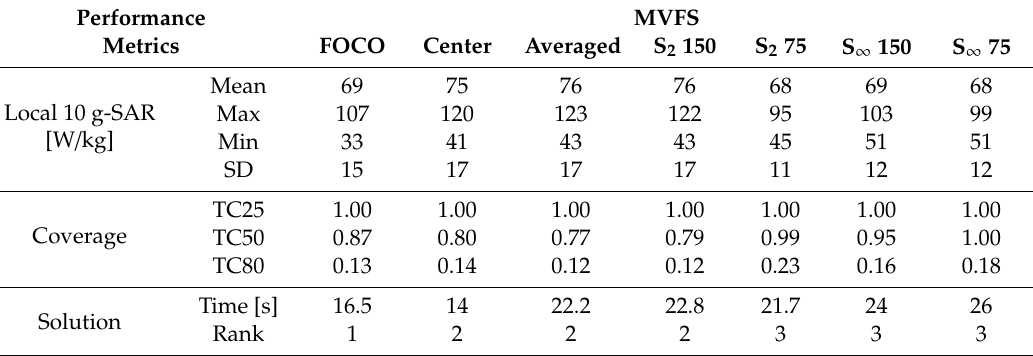
Table 2. Comparison of multiplexed vector field shaping (MVFS) to focused constrained power optimization (FOCO) for the single tumor model using 40 channels and single frequency fields at 600 MHz. Results are separated into SAR statistics, tumor coverage, and solution details. FOCO was performed using a rank-1 approximation of the central tumor SAR matrix and compared to six di ff erent MVFS application scenarios. “Center” uses the full-rank central SAR matrix, “Averaged” utilizes a single target matrix built from averaging over the whole tumor volume. The remaining four examples used all 257 tumor SAR matrices to derive a field shaping (“S”) result. Here, the subscript defines the target norm used (either 2 or ∞ ) and the following number stands for the target SAR in W / kg (either 75 or 150 W / kg). The “Rank” row describes how many time-interleaved solutions were identified for the respective solution. As expected, the FOCO solution was of rank 1 while MVFS provided multiple excitations to better cover the target volume. The results for S 2 150 are visualized in Figure 6a–f. Performance